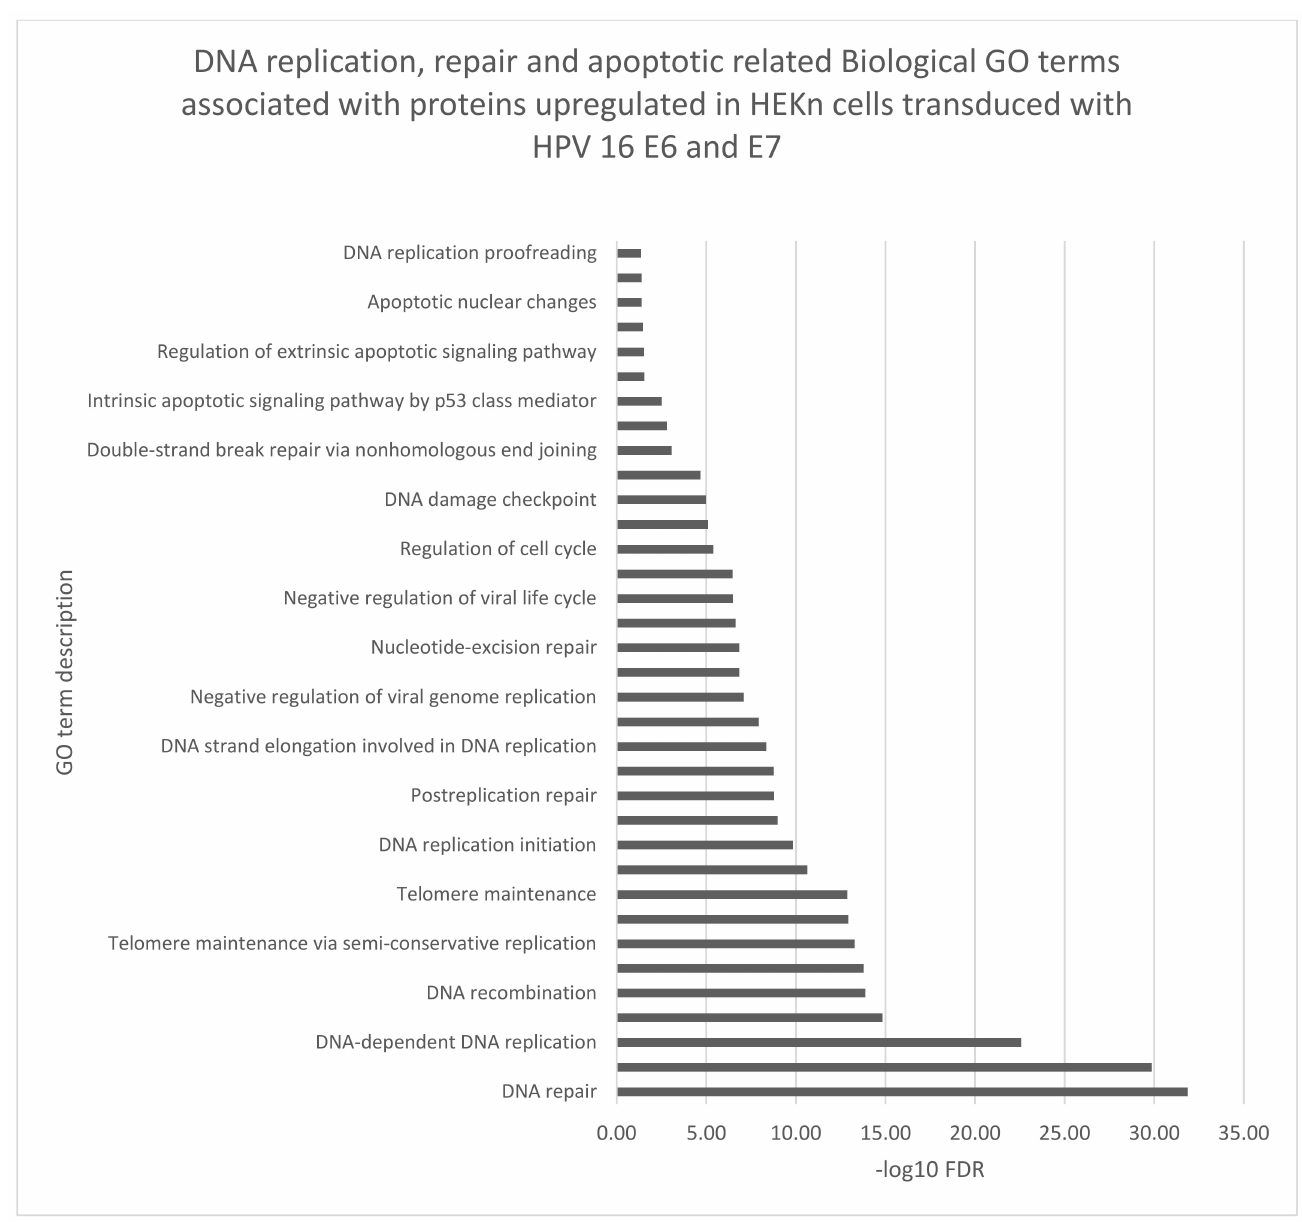
Figure 5. Biological GO terms related to DNA damage and apoptosis were associated with the proteins with significantly increased expression (adjusted p -value ≤ 0.02) by ≥± 1.5-fold change in keratinocytes transduced with HPV16 E6 and E7. FDR (False discovery rate). Finally, thirty-two biological GO terms associated with epidermal differentiation, keratinization and cytoskeletal organization were associated the proteins with significantly reduced expression (Figure 6). This group of significantly downregulated proteins includes several keratins, small proline rich proteins (SPR1A, SPR1B, SPRR2D, SPRR3, and SPRR4), desmocollins (DSC1, DSC2) which may influence the epidermal